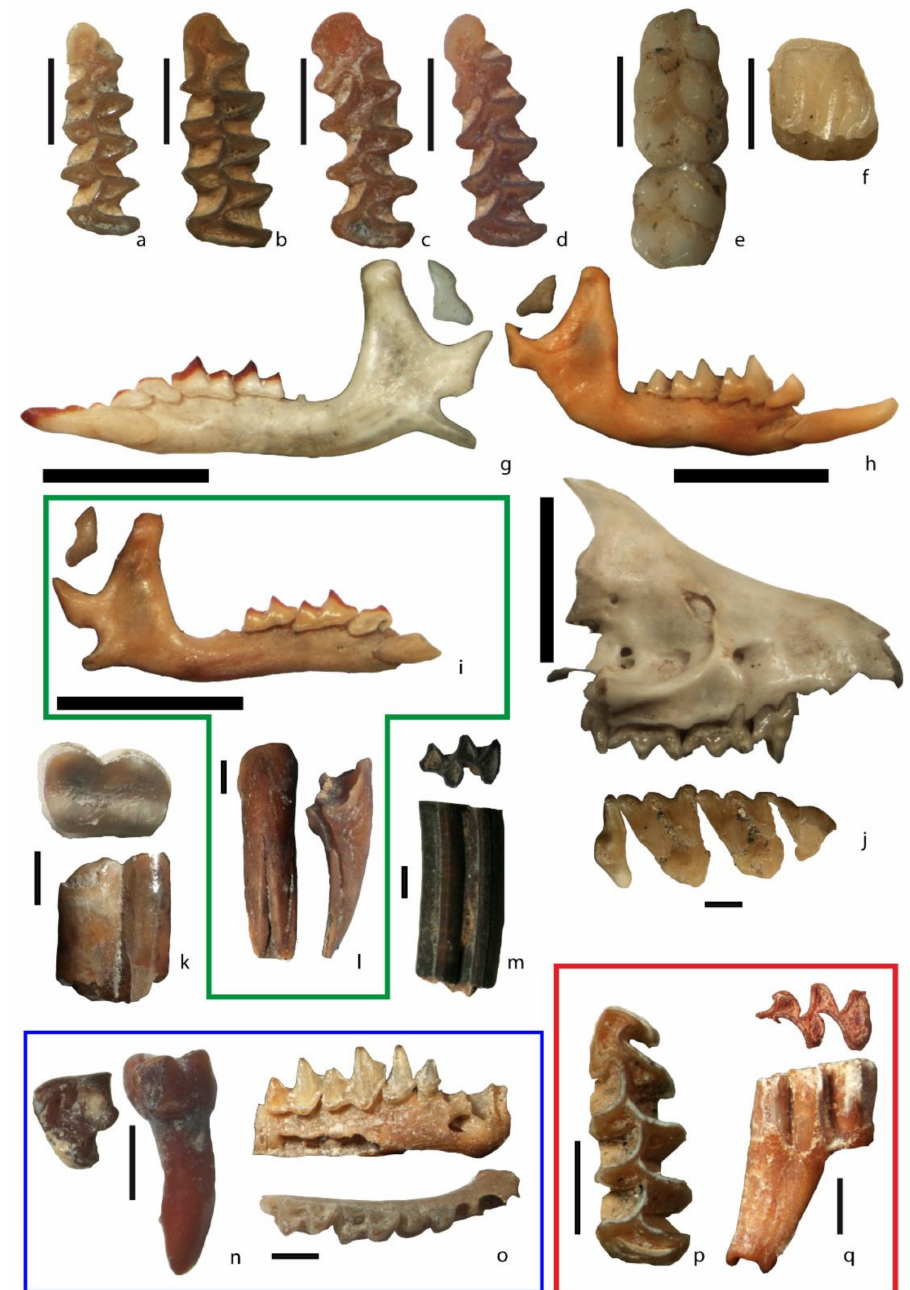
Figure 5. Diagnostic elements of the different taxa present at El Portal ó n de Cueva Mayor Late Chalcolithic habita- tional/stabling context, highlighting the taxa which are particular to specific floors: ( a ) Microtus arvalis , left m1 (occlusal view); ( b ) M. agrestis , left m1 (occlusal view); ( c ) M. ( Terricola ) duodecimcostatus , left m1 (occlusal view); ( d ) M. ( T. ) lusitanicus , left m1 (occlusal view); ( e ) Apodemus gr. sylvaticus-flavicollis , right m1-m2 (occlusal view); ( f ) Eliomys quercinus , left m1 or m2 (occlusal view); ( g ) Sorex gr. araneus-coronatus , right mandible with i1-a1-p4-m1-m2 (lateral view) and condyle detail (posteroventral view); ( h ) Crocidura suaveolens , left mandible with i1-p4-m1-m2-m3 (lateral view) and condyle detail (posteroventral view); ( i ) Sorex minutus , right mandible with p4-m1-m2 (lateral view) and condyle detail (posteroventral view); ( j ) Myotis gr. myotis-blythii right maxilla with P4-M1-M2-M3 (lateral and occlusal views); ( k ) Oryctolagus cuniculus , left I1 (occlusal and buccal views); ( l ) Talpa sp., 3 rd phalanx (dorsal and lateral views); ( m ) Arvicola sapidus , right M2 (occlusal and lingual views); ( n ) Sciurus vulgaris , right p4 (occlusal and posterior views); ( o ) Miniopterus schreibersii , right mandible with p3-p4-m1-m2 (lateral and occlusal views); ( p ) Chionomys nivalis , left m1 (occlusal view); ( q ) Pliomys lenki , left m2 (occlusal and buccal views). Red, only in the prepared floors; green, only in the fumiers; blue, only in the prepared and activity floors. Scale bars of a–f, j (lower), k–q = 1 mm; g–j (upper) = 5